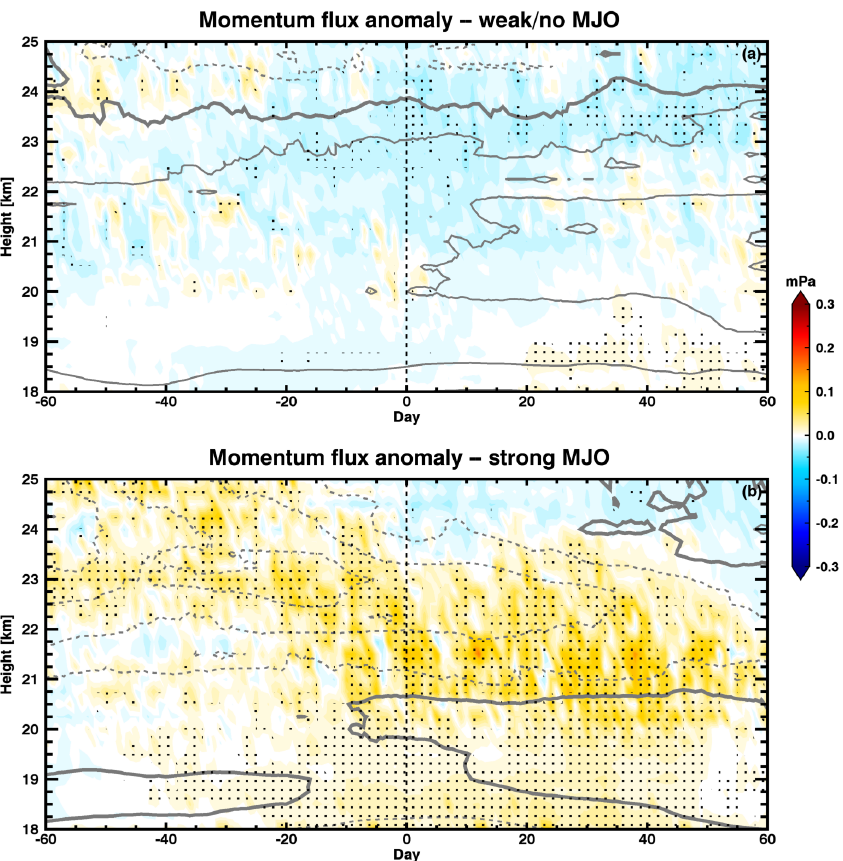
Figure 10. As in Fig. 9, but for subsets of events from those used in Fig. 9 that are (a) weakly associated with the MJO and (b) strongly associated with the